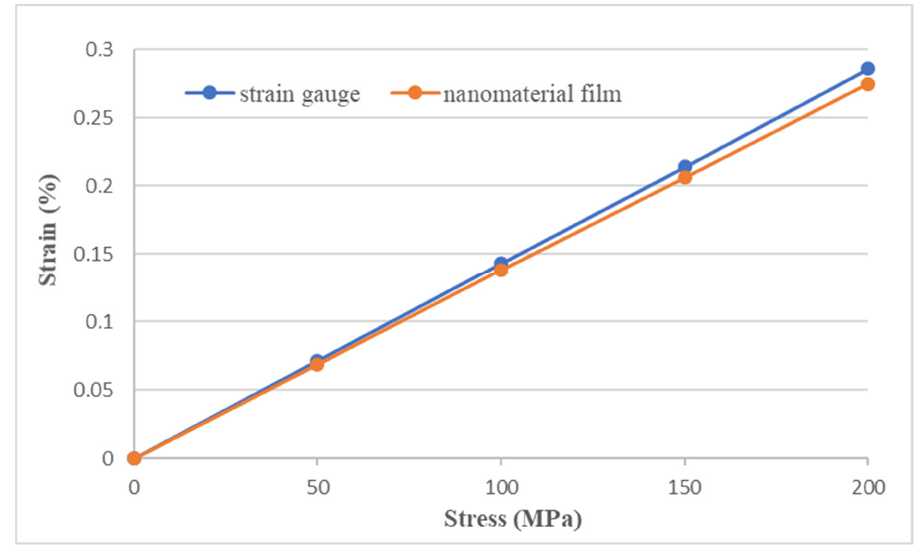
Figure 14. Strains of the Al specimen measured by the strain gauge and nanomaterial film sensor with strain sensitivity of 2.87.